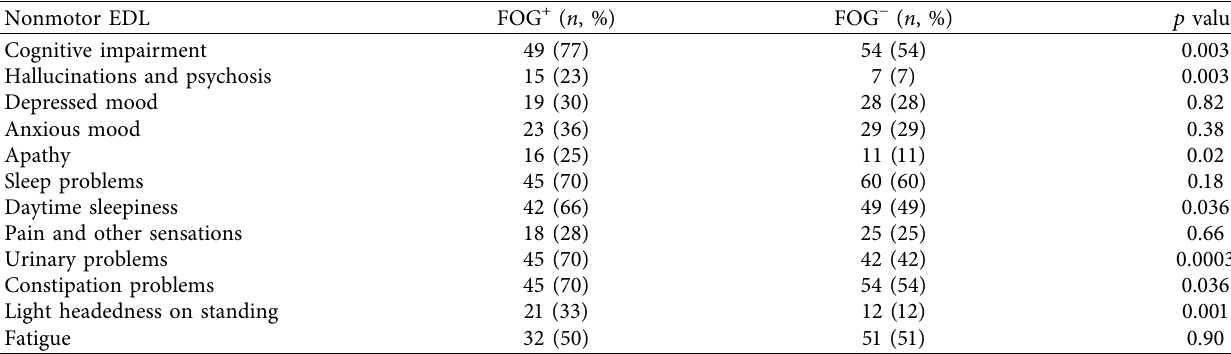
Table 2: Frequency of nonmotor experiences of daily living in subjects with and without freezing of